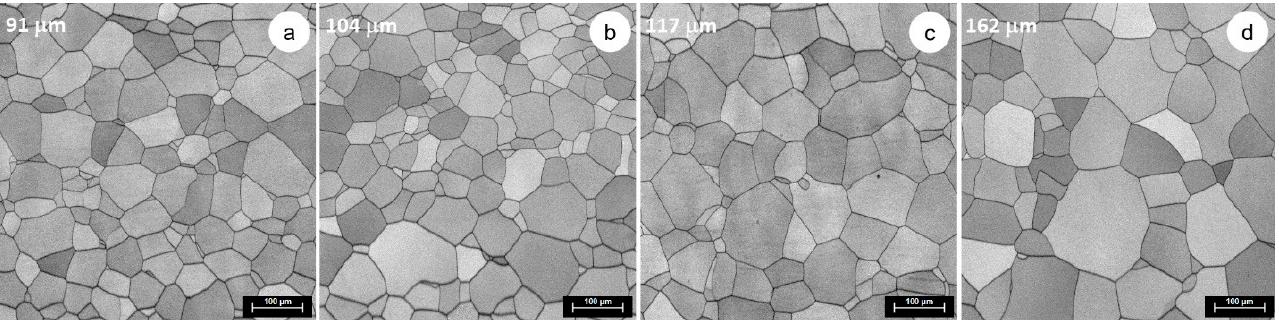
Figure 9. Evolution of the TNTZ alloy microstructure during ST treatment performed at 1000 °C for: 5 min (ST 3.1)—( a ); 10 min (ST 3.2)—( b ); 15 min (ST 3.3)—( c ); 20 min (ST 3.4)—( d ).